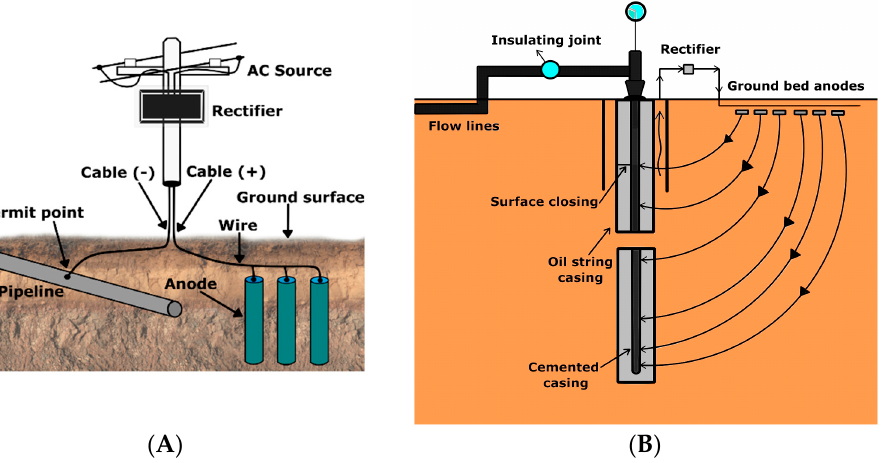
Figure 8. Impressed current cathodic protection: ( A ) buried pipelines [87], ( B ) well casing